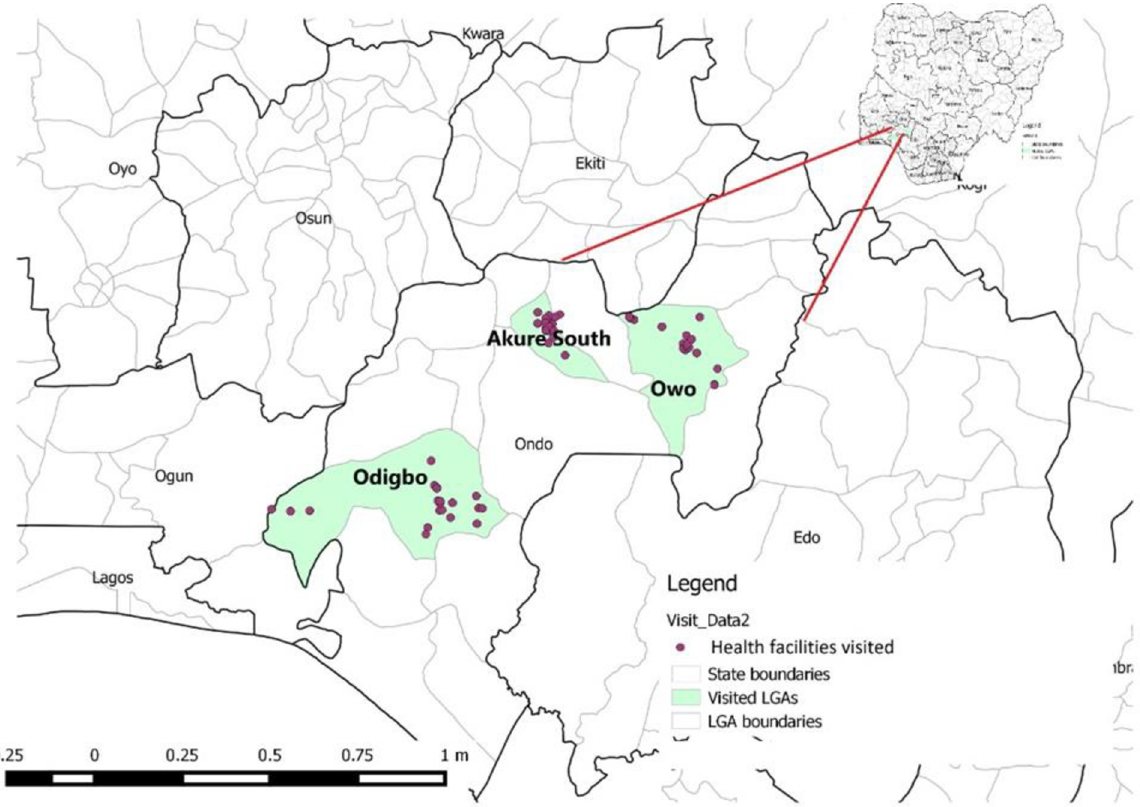
Fig 1. Map of Ondo State, Nigeria showing the selected local government areas (LGAs) and health facility locations for the 2019 Missed Opportunities for Vaccination (MOV) assessment.